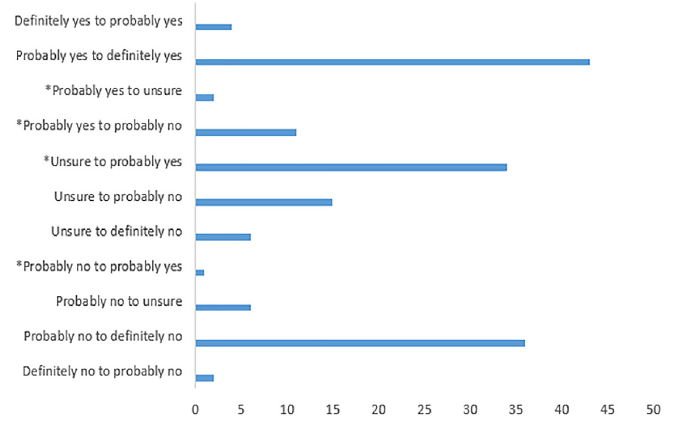
Figure 2. The degrees of change in “likelihood to invite” before and after Medical Student Performance Evaluation (MSPE) review for applications where MSPE review resulted in a change of at least 1 point on the Likert